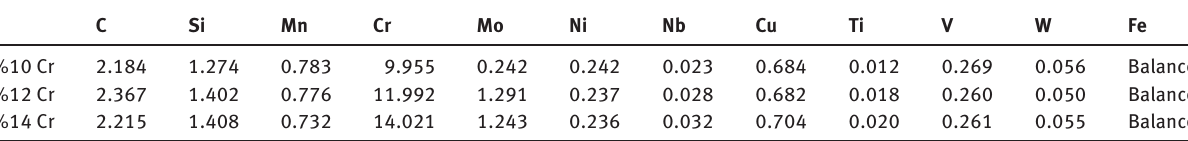
Table 1: Chemical compositions of valve seat